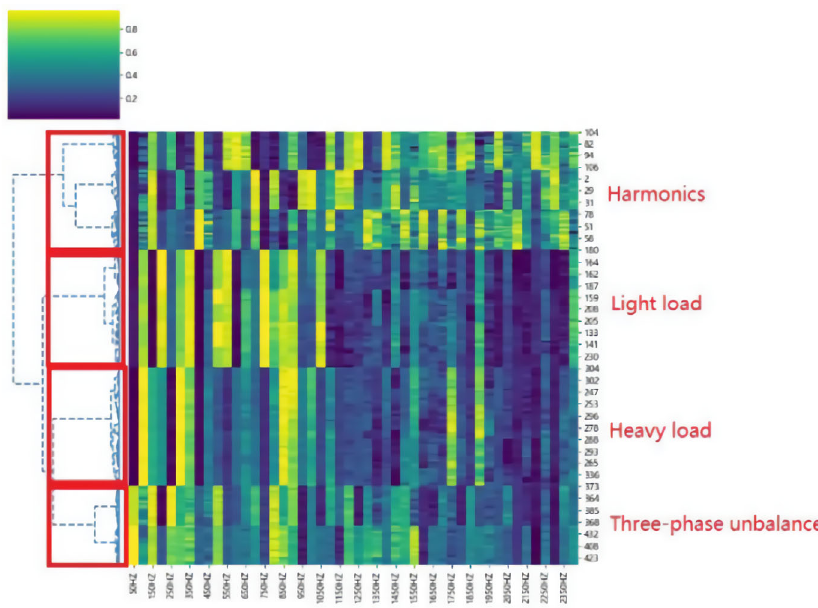
Figure 5. Heatmap using the ward connection mode condensation hierarchy.